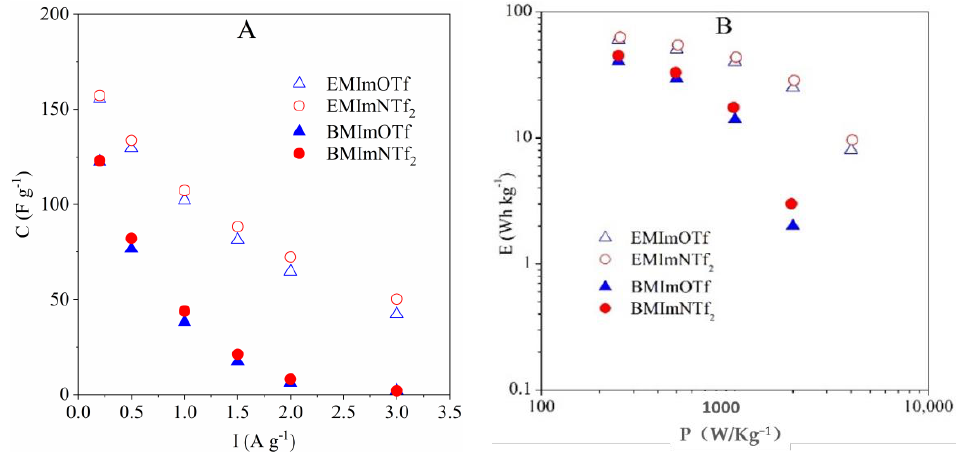
Figure 8. ( A ) Discharge capacitance vs. current and ( B ) Ragone plot of the ECs with various ionogels. Capacitance, energy and power calculated per mass of AC in one